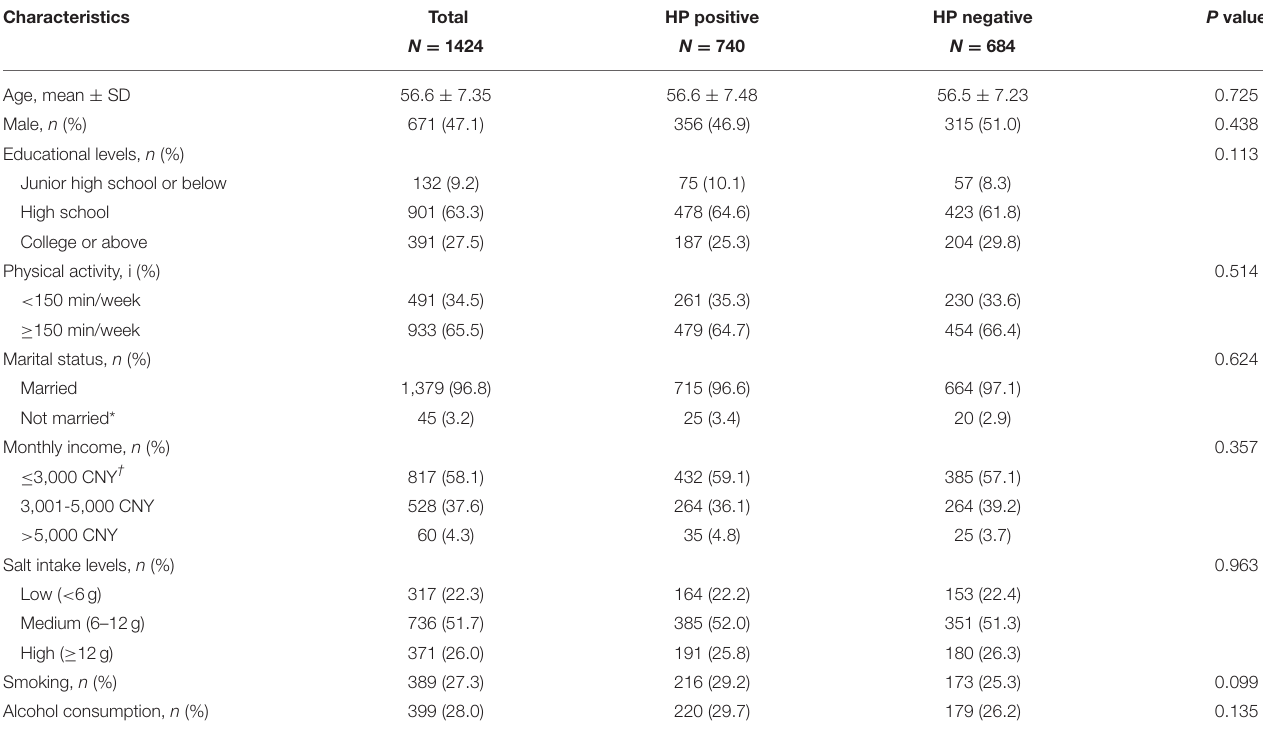
TABLE 1 | Comparison of baseline characteristics in participants with different statuses of HP infection.